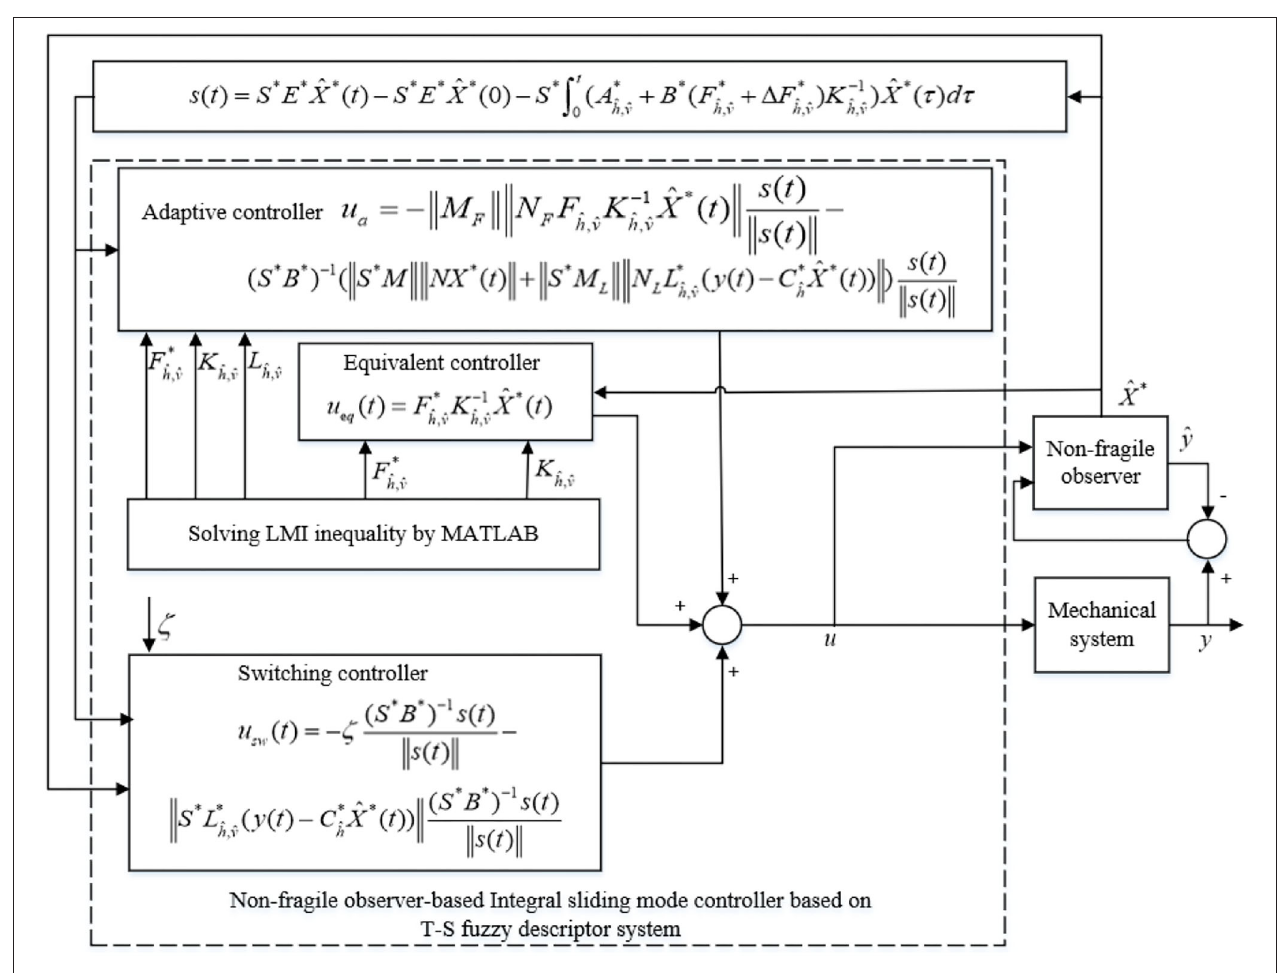
FIGURE 1 | Non-fragile observer-based ISMC for T-S fuzzy descriptor